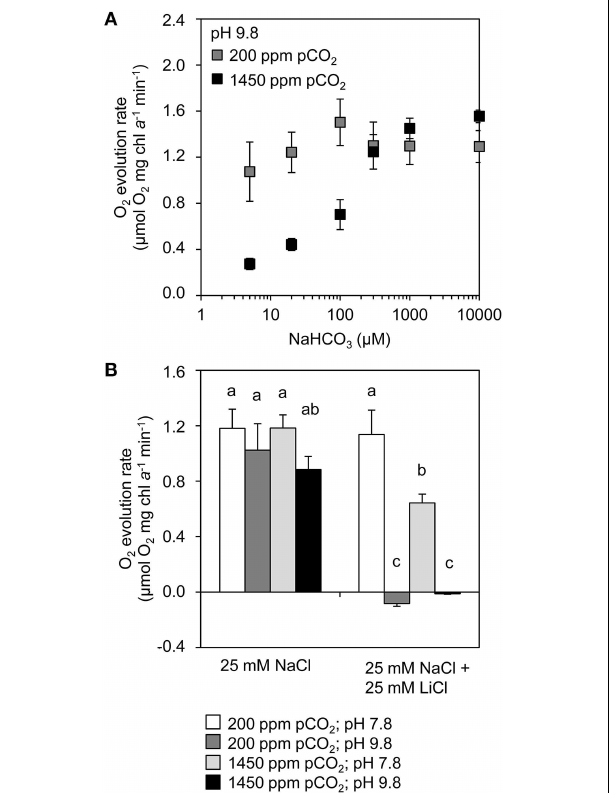
FIGURE 6 | Inorganic carbon uptake kinetics of cells grown at low pCO 2 (200 ppm) and high pCO 2 (1450ppm). (A) Bicarbonate response curves (O 2 evolution rates) of cells grown at low vs. high pCO 2 after addition of different concentrations of NaHCO 3 at pH 9.8. (B) O 2 evolution rates in the presence and absence of LiCl, at pH 7.8 and pH 9.8. The cells were provided with 200 µ mol L − 1 KHCO 3 . Lithium ions block sodium-dependent bicarbonate uptake, while differences in pH produce different concentrations of dCO 2 and bicarbonate. Error bars indicate standard deviations ( n = 4 ). Bars with different letters were significantly different, as tested by a one-way analysis of variance with post-hoc comparison of the means ( α =